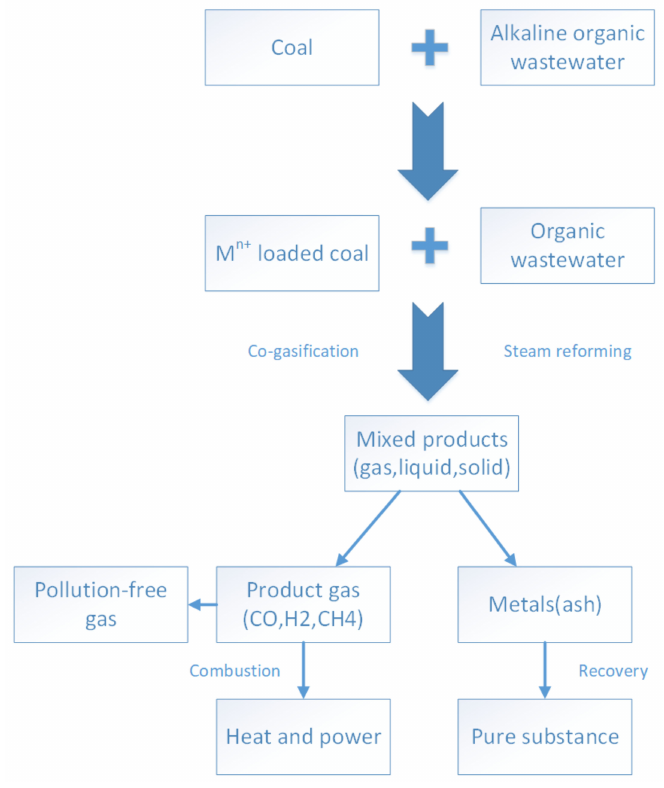
Figure 1. Gasification combined with combustion